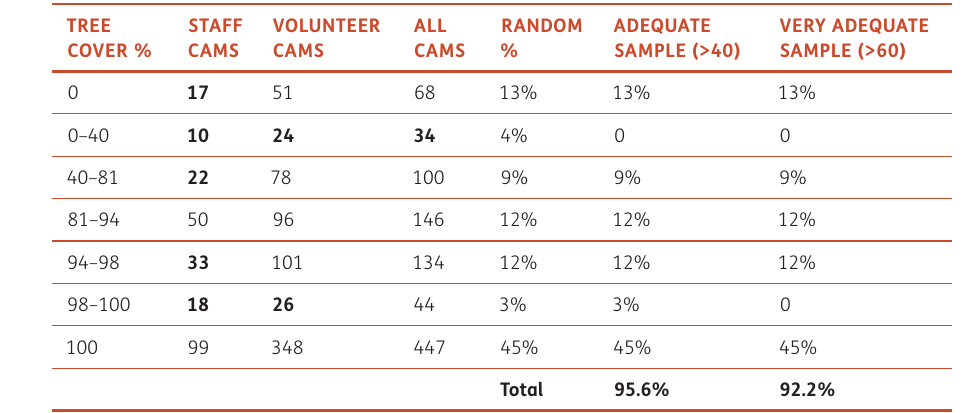
to inform our models. At each percentage, we randomly